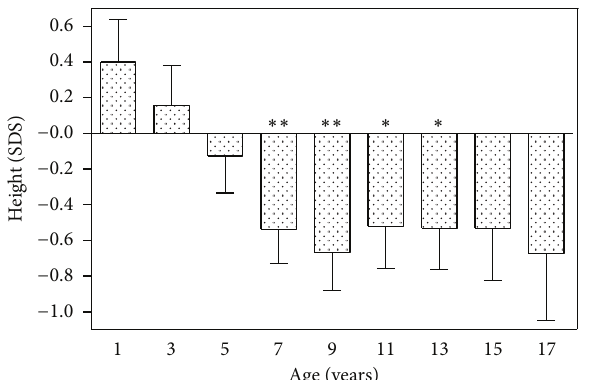
Figure 1: Body length/height (expressed as height SDS ± SEM) in 29 children with primary ciliary dyskinesia from their 1st through 17th birthdays, displaying the loss of height during childhood. ∗ 𝑃 < 0.05 and ∗∗ 𝑃 < 0.01 versus the expected value of 0 SDS.